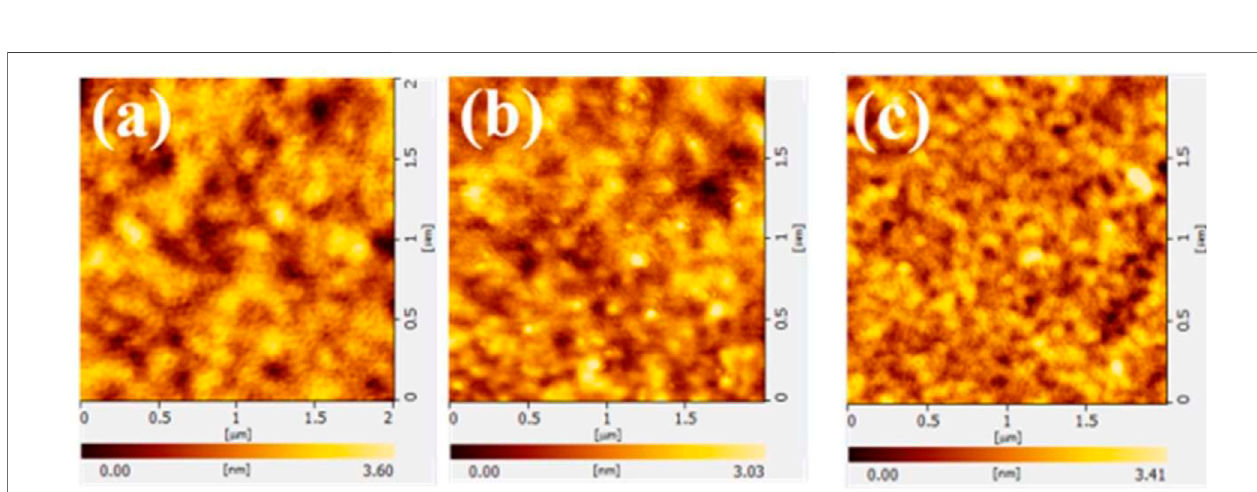
FIGURE 3 | Water contact angle measurements of different HIL of (A) PEDOT:PSS, (B) PEDOT:PSS/10% ZnS QDs and (C) PEDOT:PSS/10% MoS 2 QDs.